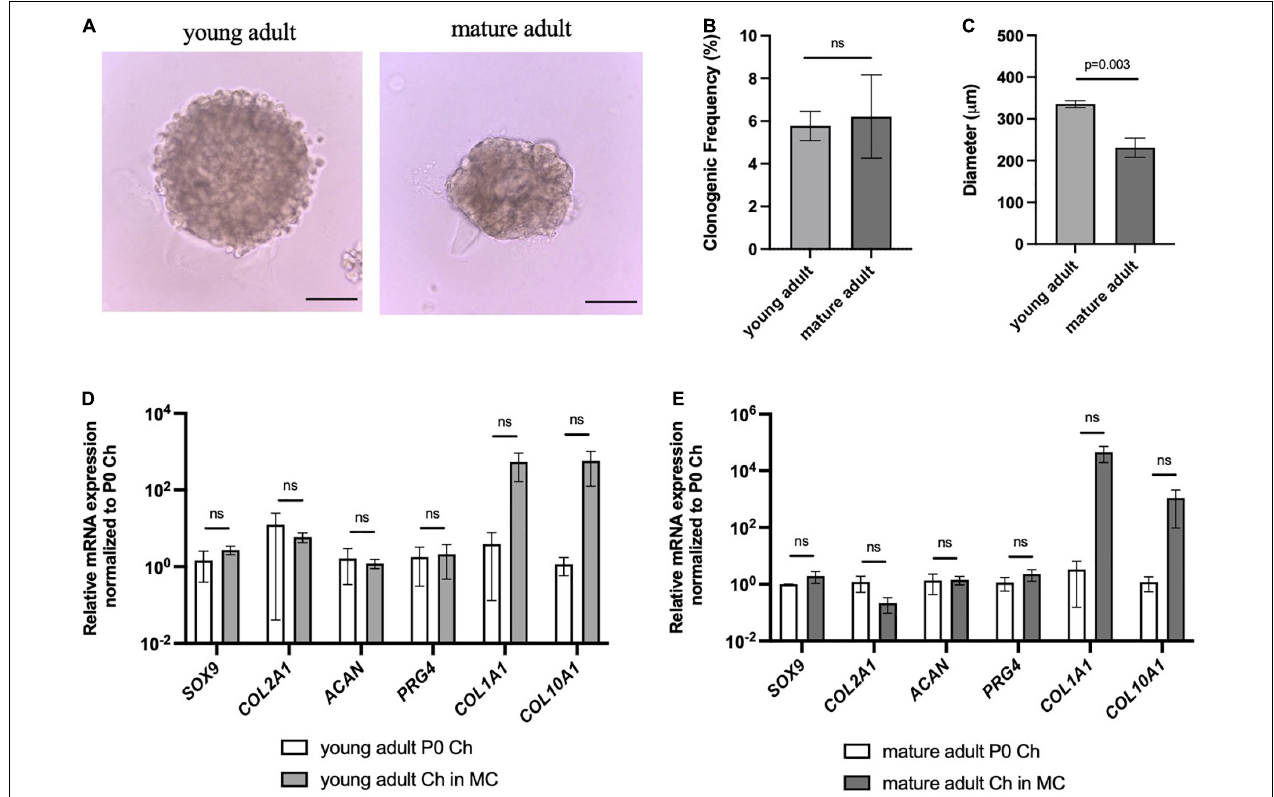
FIGURE 6 | Human articular chondrocytes of different ages demonstrate clonality and retention of chondrogenic genes in 3D culture. (A) Representative images of young and mature adult chondrospheres in MC after 4 weeks, scale bar = 100 µ m. (B) Clonogenic frequency of chondrocytes in MC, n = 2 biological replicates. (C) Diameter of chondrospheres of young and mature adult chondrospheres in MC, n = 2 biological replicates. qPCR of chondrogenic genes in young adult (D) , and mature adult (E) chondrospheres cultured in MC after normalizing expression to freshly isolated chondrocytes of respective samples, n = 2 biological replicates. Data represented as mean ± SEM and p -values calculated using an unpaired t